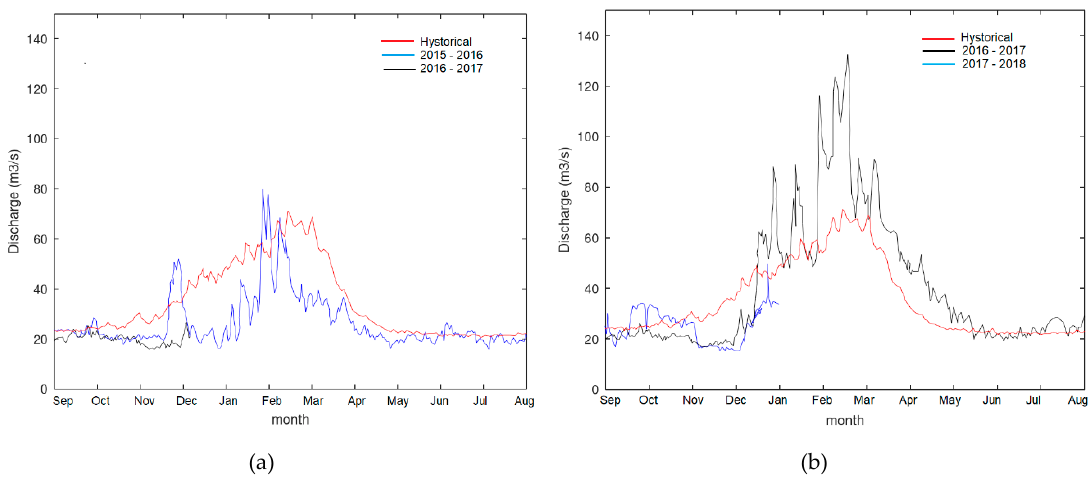
Figure 3. Historical and El Niño discharges of the Rimac River. ( a ) Discharges in a normal year from September 2015 to January 2016. ( b ) Discharges when an El Niño (EN) occurred from September 2016 to February 2018. Figure was reproduced from ENFEN (Estudio Nacional del fen ó meno EL NIÑO) public domains reports